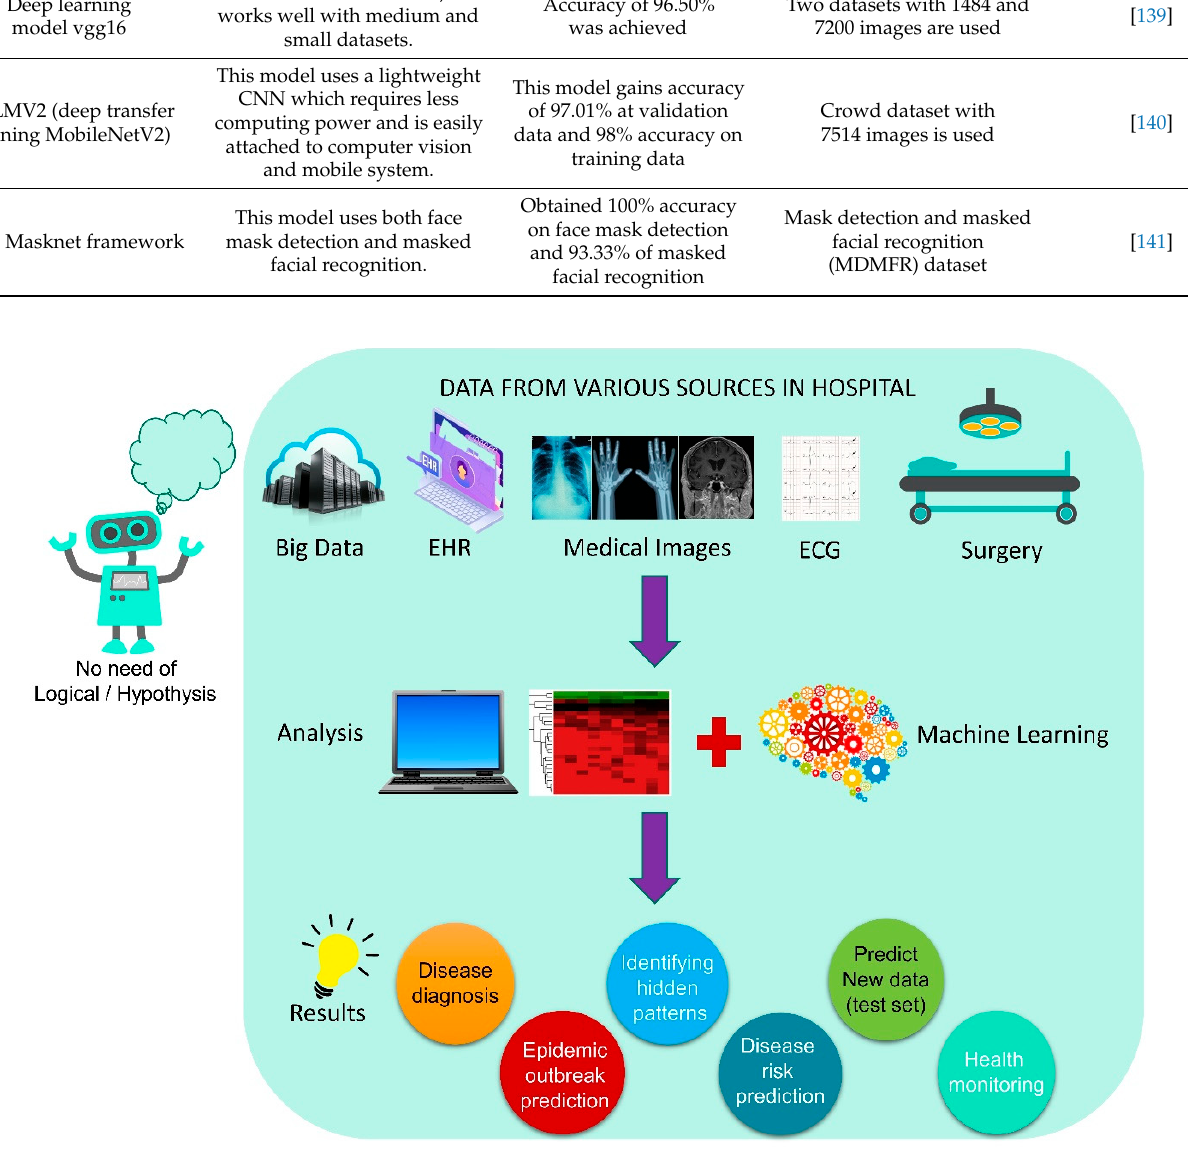
Figure 8. Various applications of ML driven from hospital data.